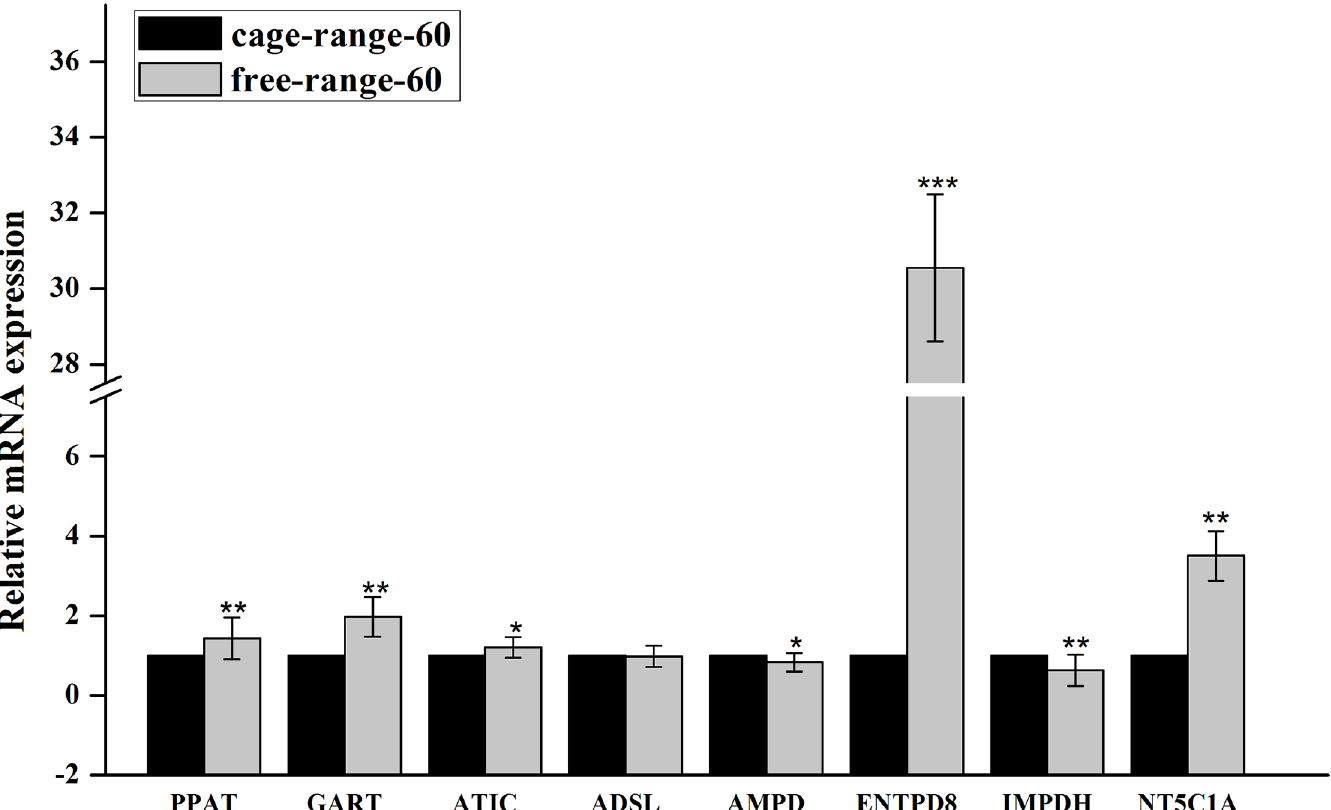
Fig 5. Expression levels of seven IMP-related genes validated by qPCR in thigh muscles from 60-day-old caged and free-range Chickens.